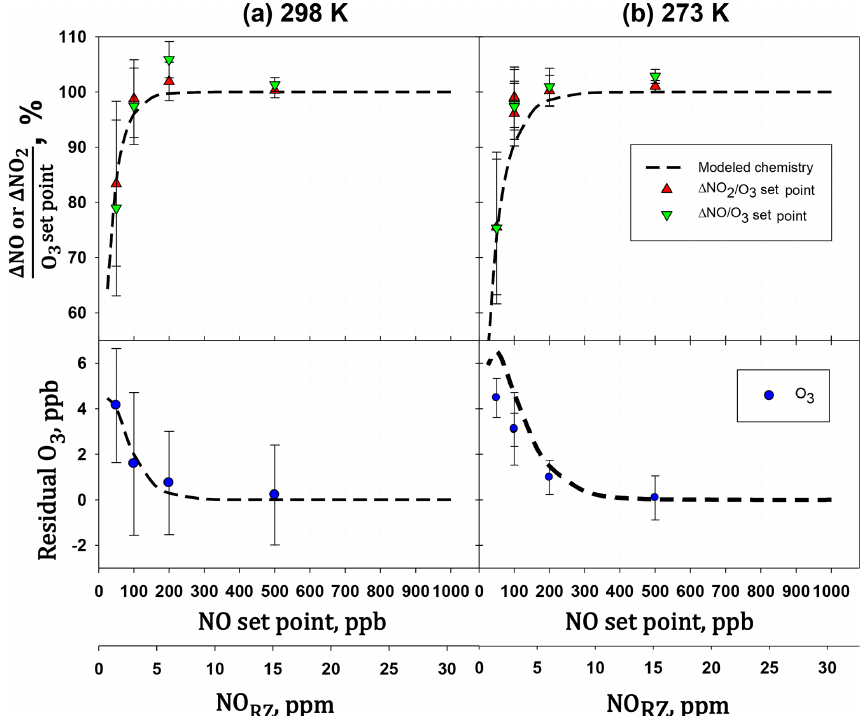
Figure 12. Plots of the amount of NO consumed ( (cid:49) NO / O 3 set point) and NO 2 formed ( (cid:49) NO 2 / O 3 set point vs. the NO set point. A second x axis of the NO concentration in the reaction zone (NO RZ ) is also given as a reference to Fig. 1. Measurements were made with the reaction zone at (a) 298K and (b)